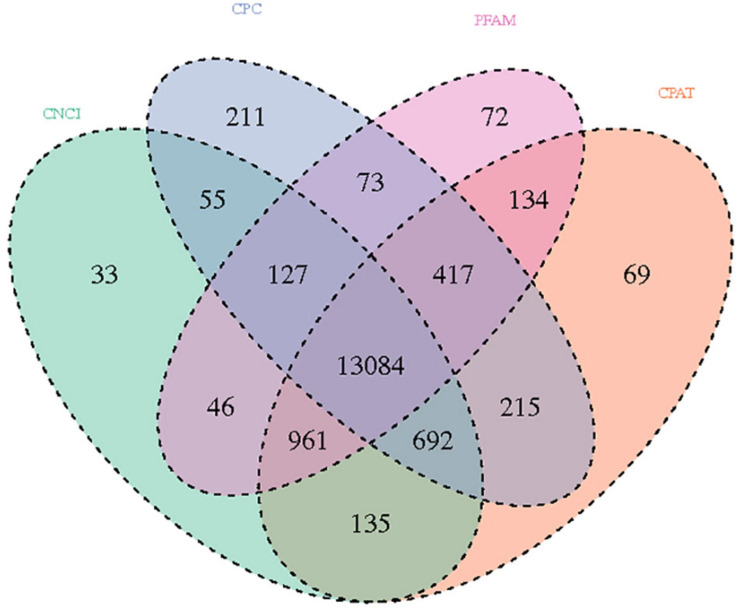
Venn diagram showing the total and unique lncRNA numbers predicted by CNCI, CPC, FPAM, and CPAT.